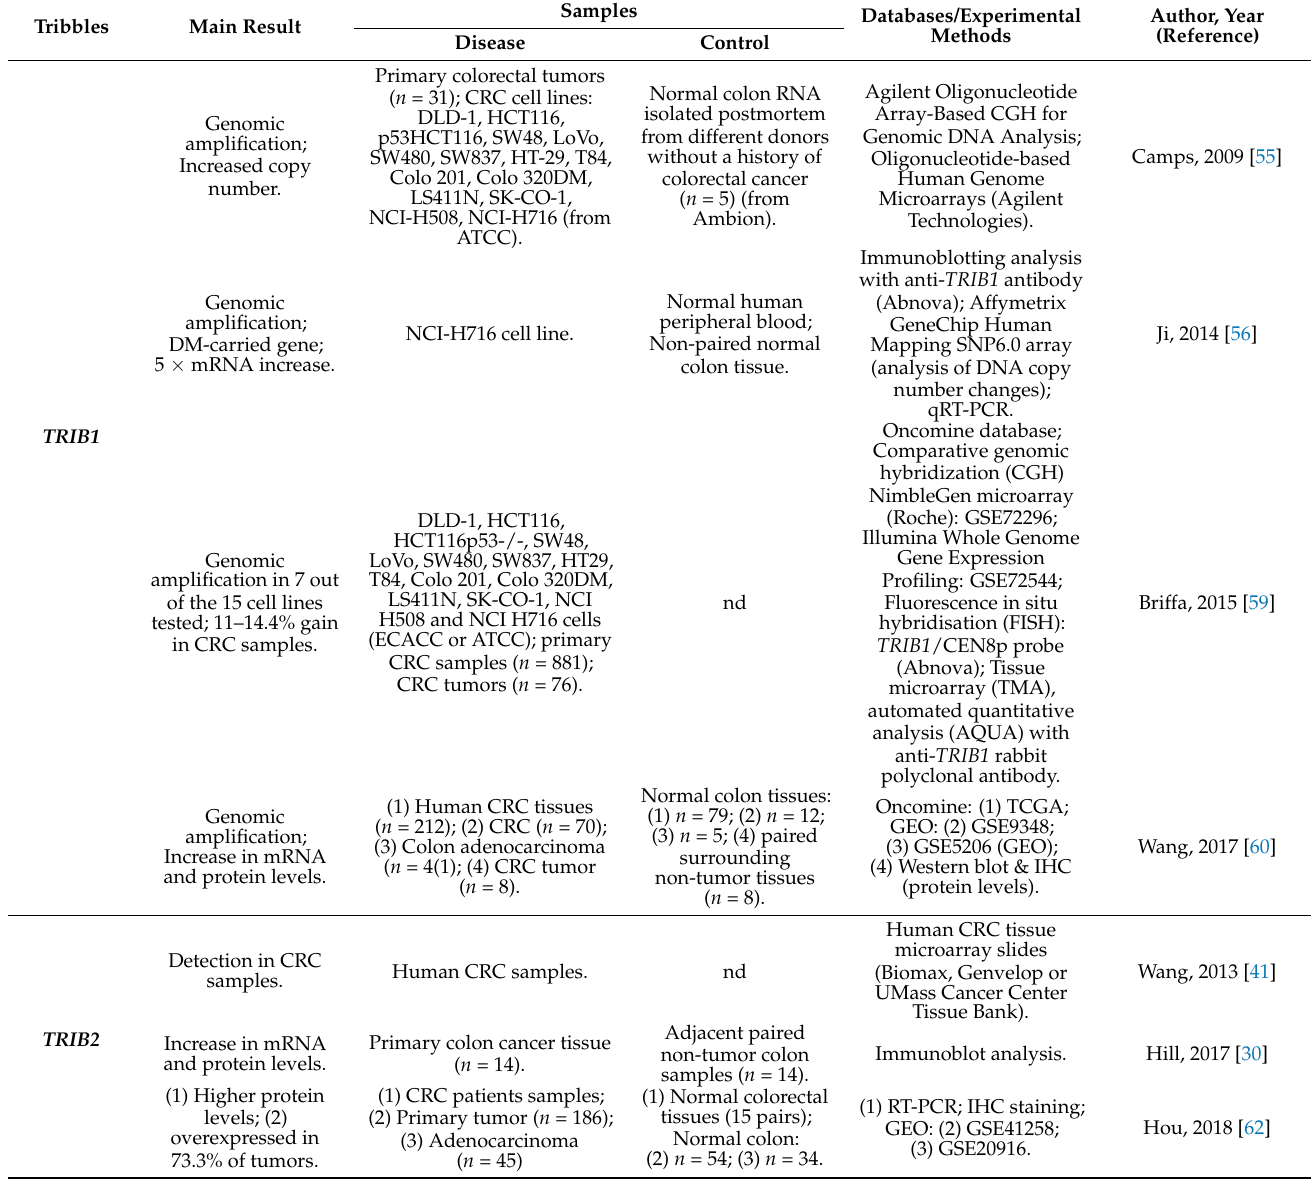
Table 1. Tribbles amplification and overexpression in colon cancer tissues. Main result obtained for each study included in the section is shown for each Tribble member. Details of the samples, databases and methodology used by the authors is detailed under respective column. Whenever available, the number of samples analyzed is specified under n . nd, not